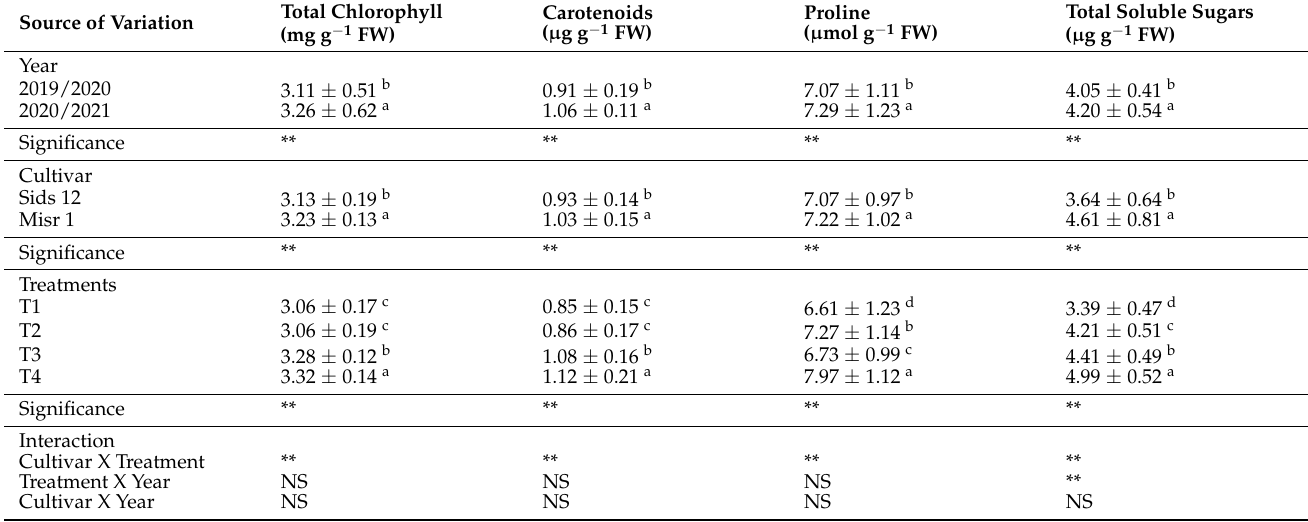
Table 2. Impact of different treatments (EM, CT, and combination) on physiological characteristics of wheat plants at 70 days after sowing, during the two growing seasons.